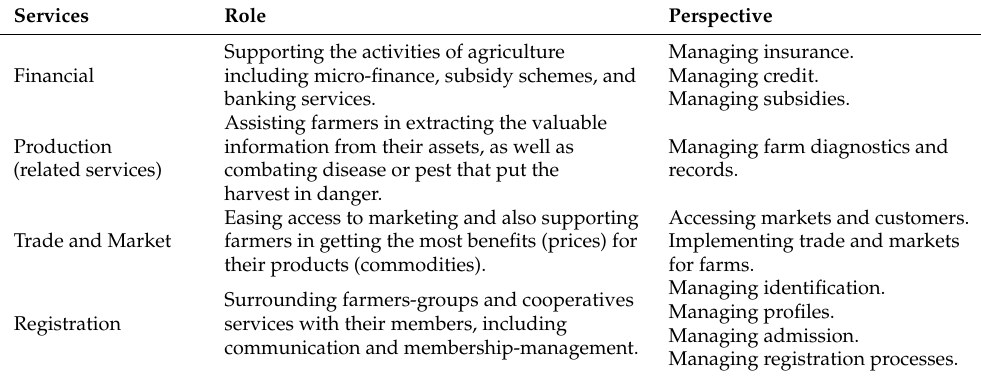
Table 2. Big data analytics services from a business point of